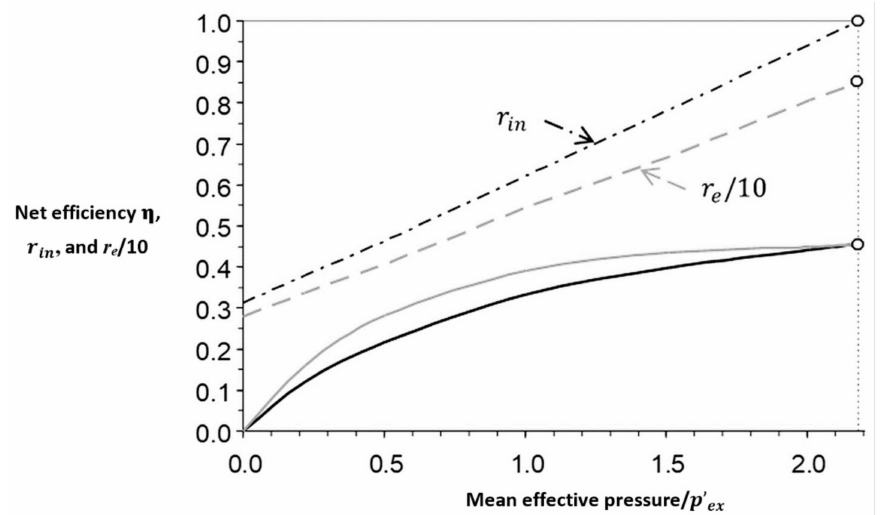
Figure 5. Effect on efficiency of alternative methods of partializing load for cycles with constant γ and γ b . Conventional throttling (reducing r in but r and r e = cnt.), indicated with black lines, and LIVC (reducing r e but r and r in = cnt.) indicated with gray lines. Full load corresponds to both r in = 1.0 and r e = 8.5, yielding mep / p (cid:48) ex = 2.18, as indicated. η com,int,v = 0.95; J com = 0.9; r = 10.0; α = 1.5; β = 1.0; γ = 1.4; γ b = 1.3.